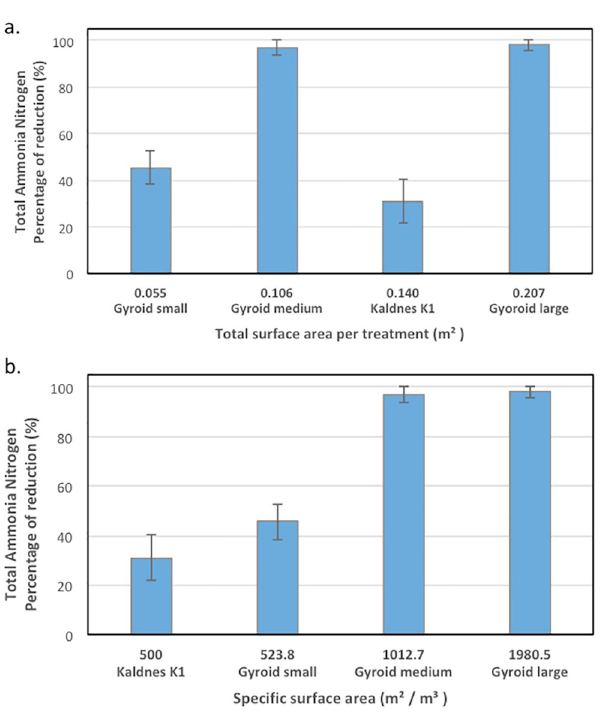
Fig 6. Total ammonia conversion for each biocarrier as a function of (a) total surface area per treatment, and (b) specific surface area of the biocarrier, for Experiment 1, constant fill ratio.